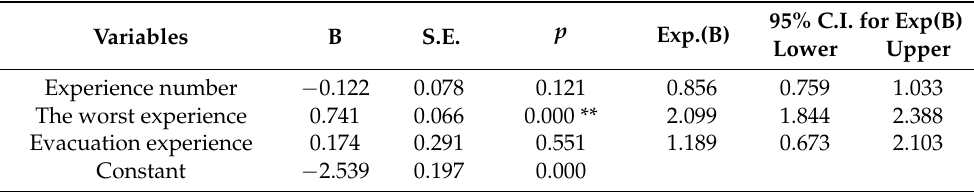
Table 7. Multiple logistic regression analysis investigating factors (disaster experience variables) relating to respondent’s preventive behaviour and disaster